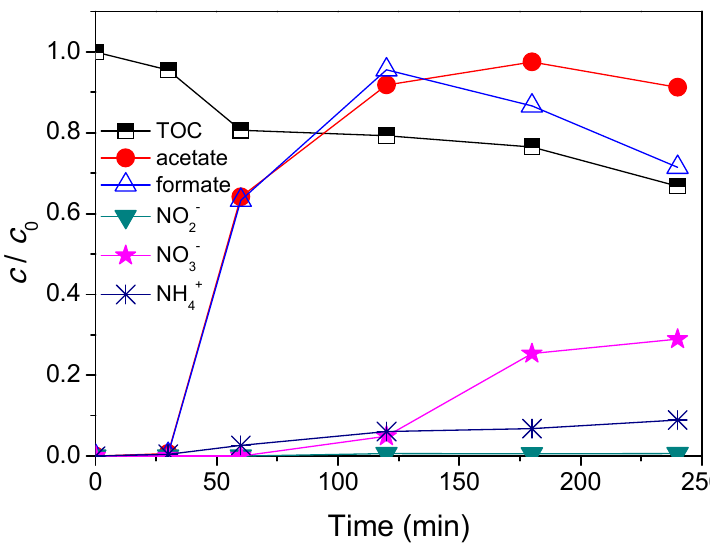
Figure 8. Degree of mineralization and evolution of different ions formed during AMI (0.0300 mmol/L) photocatalytic degradation in the presence of ZnO (1.0 mg/mL) and solar radiation.